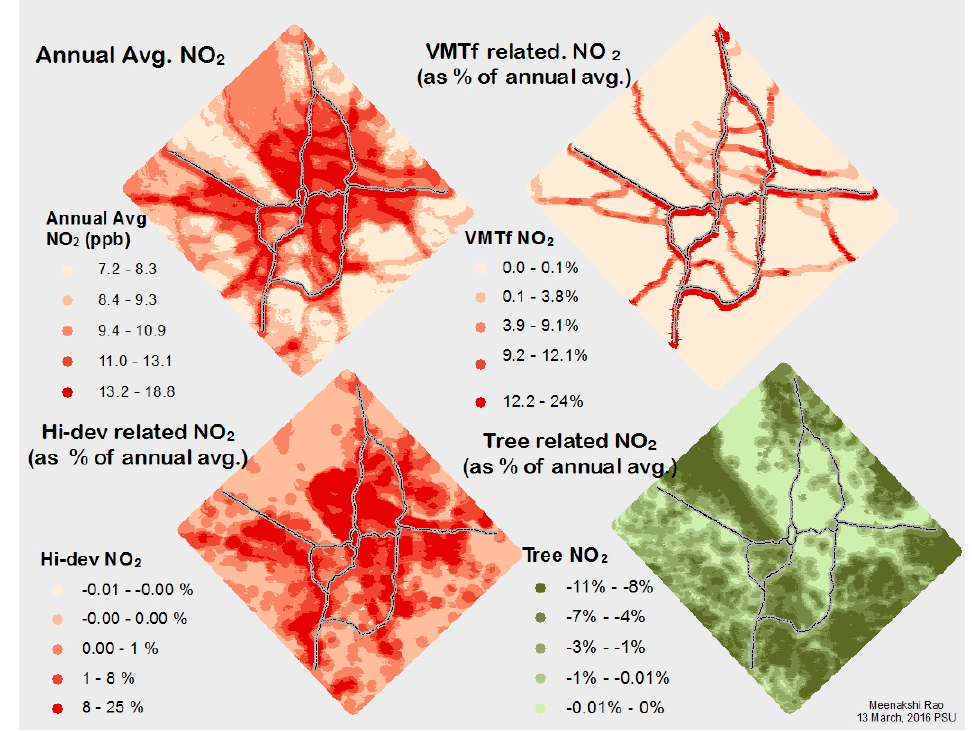
Figure 4. Percentage change in annual average NO 2 when a land use/land cover category is replaced with a neutral land use.